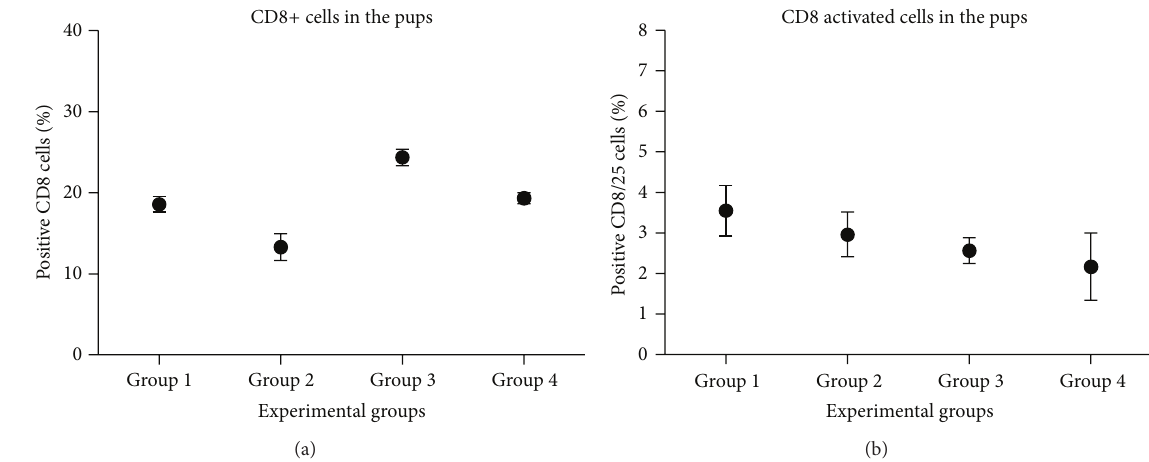
Figure 9: Assessment of total CD8 positive lymphocyte population (a) and the activated population (b). The experimental groups are displayed in the 𝑥 -axis, and in the 𝑦 -axis, the average percentage of positive CD8 cells is displayed.